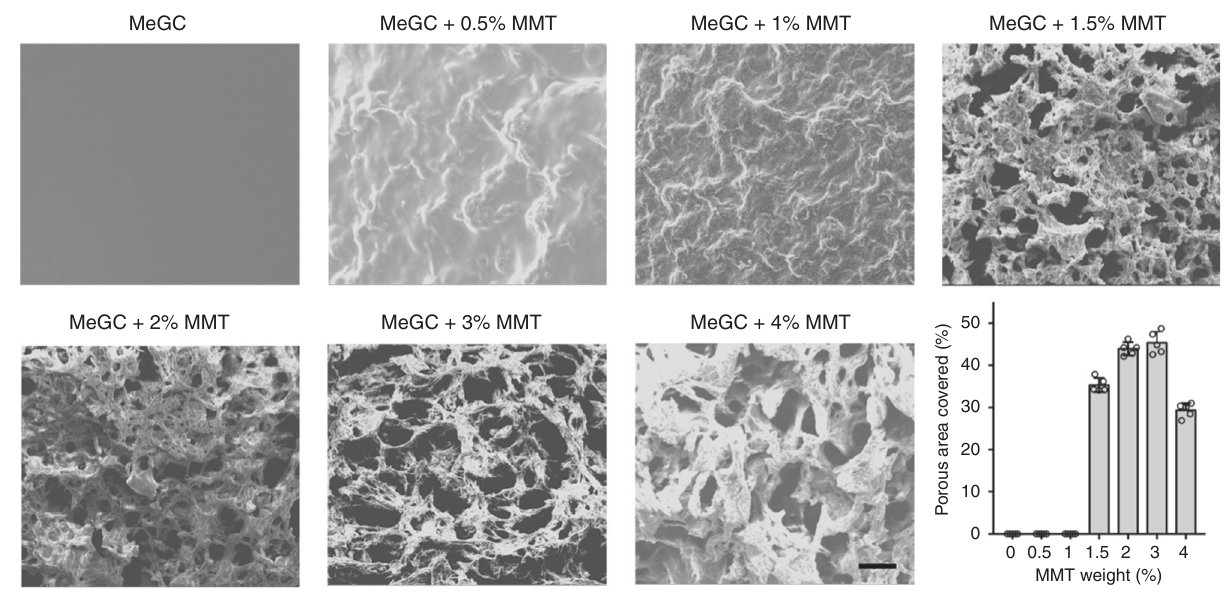
Fig. 2 Characterization of interconnected microporous structure. SEM images of photocross-linked MeGC-MMT nanocomposite hydrogels. Various amount of MMT ranged from 0 to 4% (scale bar = 100 μ m). Percentage porous area covered was quanti fi ed by SEM image analysis. Error bars indicate standard deviation